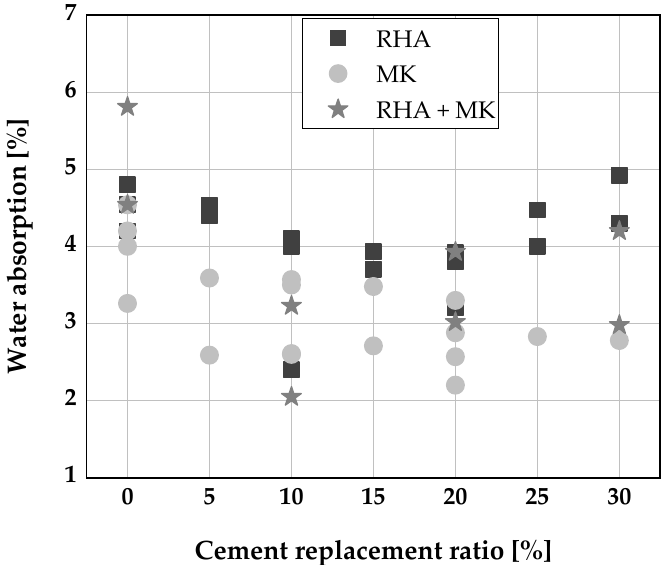
Figure 11. Water absorption of SCC produced with RHA and MK: Kannan [110], Rahman [106], Madandoust [34], Gill [135].